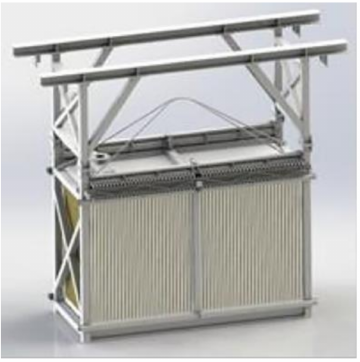
Figure 4. The membrane module of the